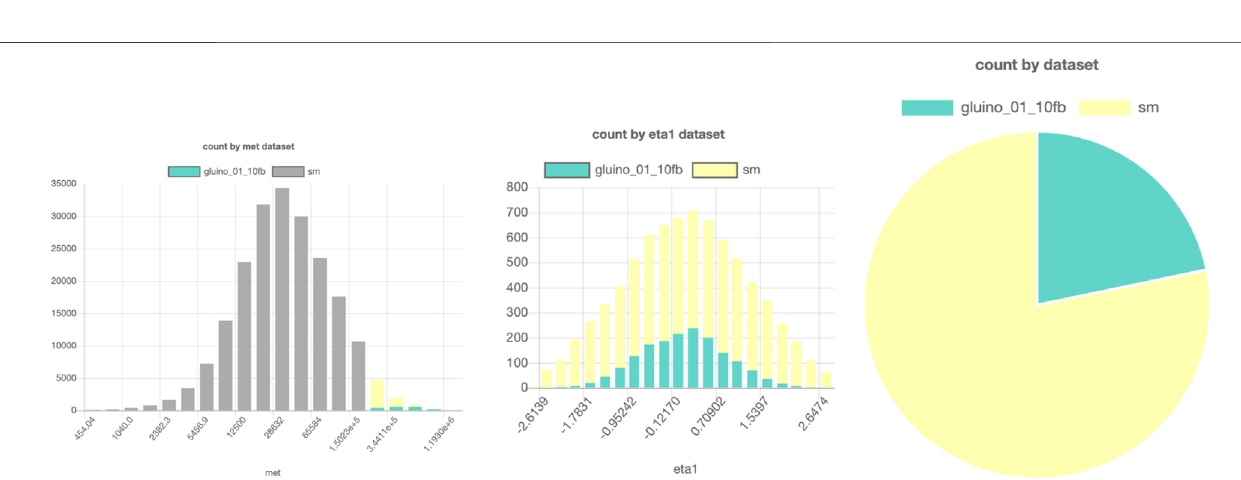
FIGURE7| SPOT-basedcomparison ofapossibleLHCsignal(here,agluinoproductionfromsupersymmetry)andbackground.Partsofa fi gurecanbeturnedoff to fi lterthemoutintheother fi gures.Inthisexample,thegraybarsinthelefthistogramareturnedoff,sointhemiddleandright fi gures,onlythedatapointswithhighMET are shown. The interactive dashboard of this dataset can be accessed